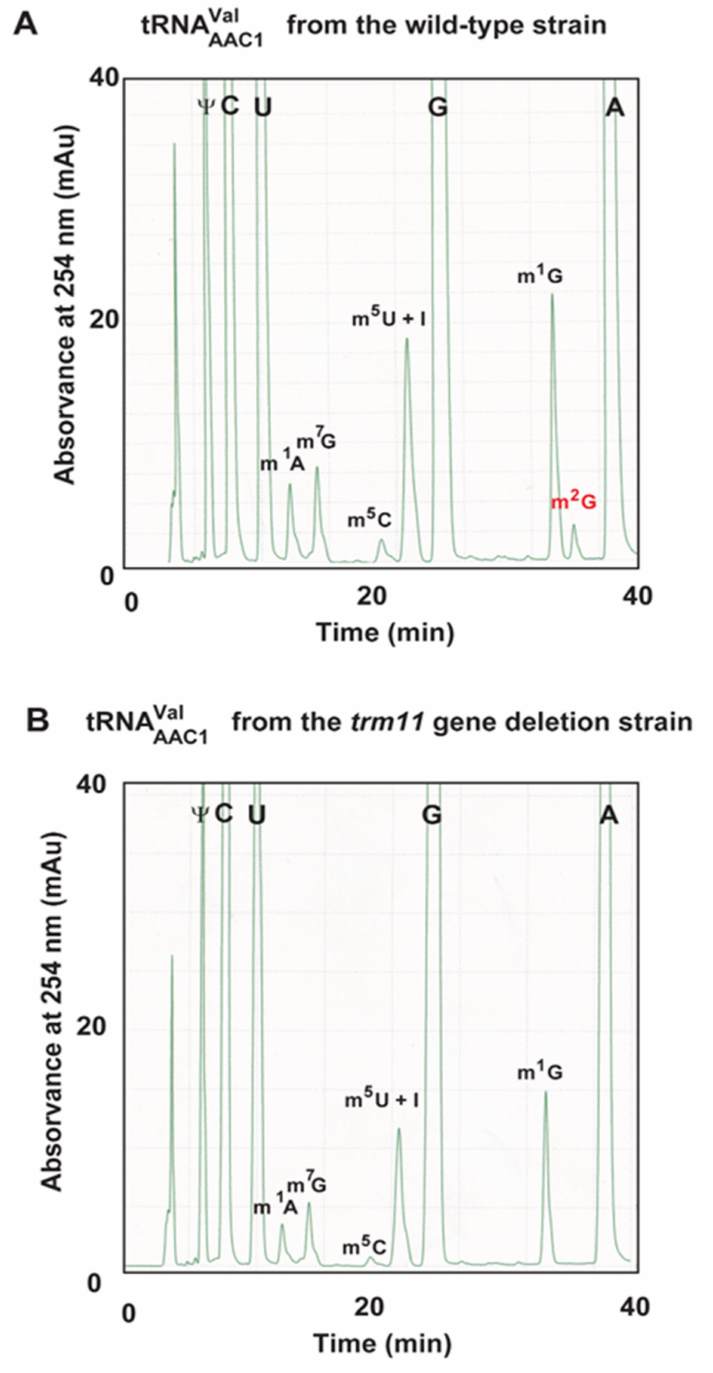
Figure 12. The m 2 G nucleoside is present in tRNA Val AAC1 from the wild-type S. cerevisiae strain but not in tRNA Val ACC1 from the trm11 gene deletion strain. ( A ) Purified tRNA Val AAC1 (0.60 A260 units) from the wild-type S. cerevisiae strain was digested to nucleosides, and then, the modified nucleosides were analyzed. The peak of m 2 G is highlighted in red. The peaks of m 5 U and I overlap. D is not visible because D does not absorb ultra-violet light at 254 nm. ( B ) Modified nucleosides in purified tRNA Val AAC1 (0.45 A260 units) from the trm11 gene deletion strain were analyzed. The peak corresponding to m 2 G is not